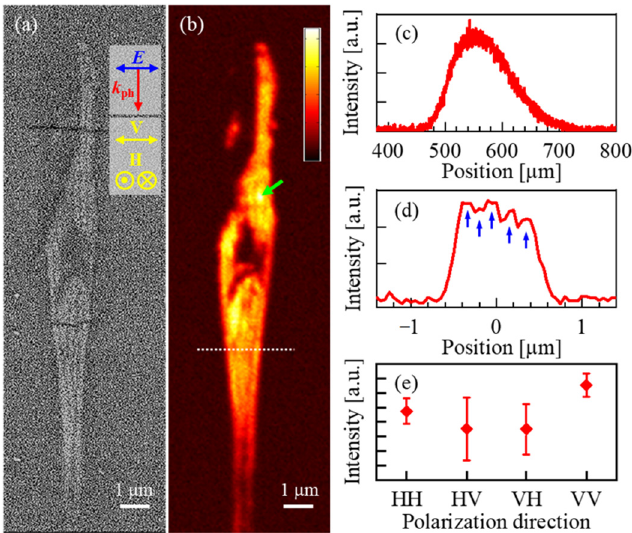
Figure 4. ( a ) Backscattering electron image (BEI) on the polished sample in the plane perpendicular to the laser traces written by the femtosecond laser pulses with 50 kHz. Symbols of E and k ph indicate the writing laser polarization and propagation direction, respectively. Symbols of V and H indicate the direction relative to the nanograting structure orientation. ( b ) Cathodoluminescence (CL) intensity map at 550 nm on the same surface in ( a ). Green arrow indicates the measurement point of CL spectrum in ( c ). Dotted white line indicates the measurement position of CL intensity profile in ( d ). ( e ) Plots of the emission intensities using confocal fluorescence microscope. Each polarization direction of the excitation light and the detection light was set to be horizontal (H) or vertical (V) with respect to the nanograting structure orientation. The arrows in ( d ) are guides for the eyes.